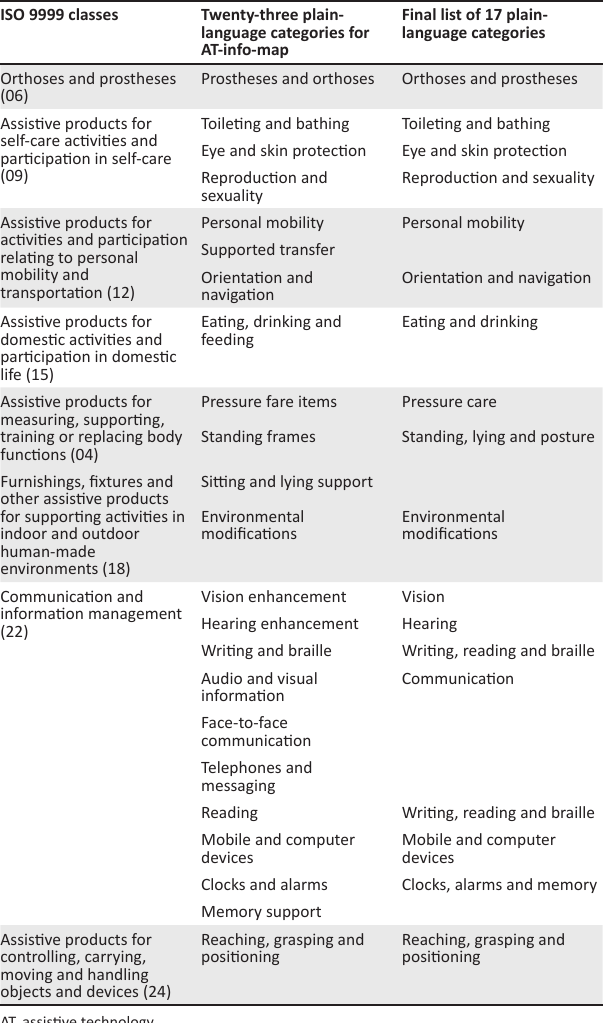
TABLE 1: The 18 plain-language categories as developed from ISO 9999 classes and subclasses. ISO 9999 classes Twenty-three plain- language categories for